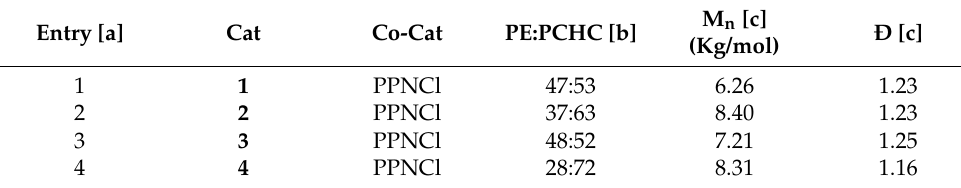
Table 3. PA/CHO/CO 2 terpolymerization promoted by complexes 1 – 4 .